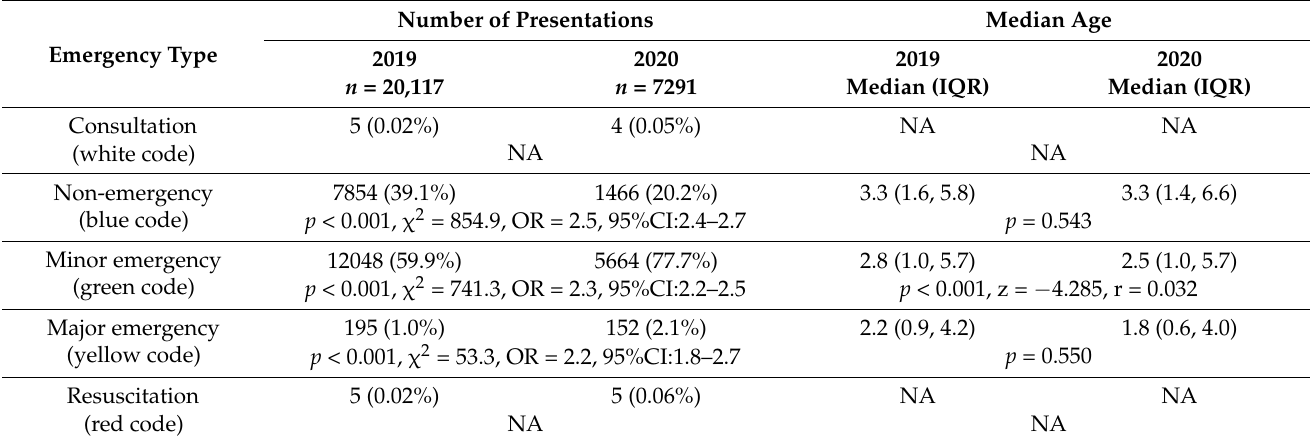
Table 1. Variation in number of presentations and median age by type of emergency.